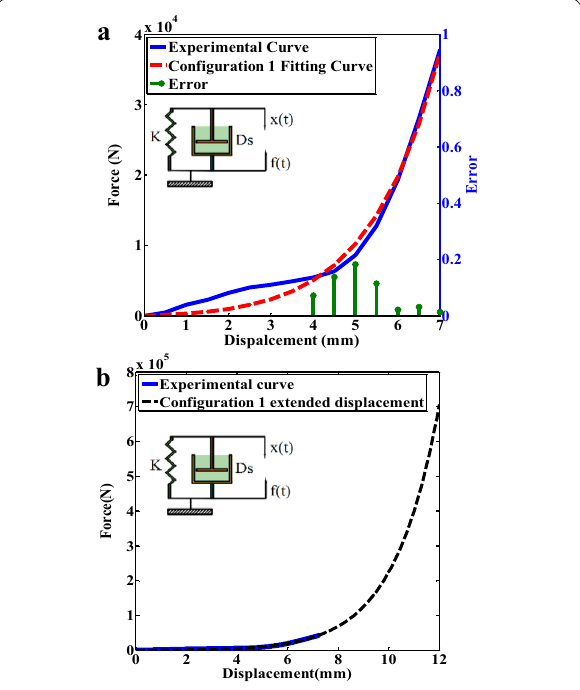
Figure 3 Configuration 1: equivalent mechanical model and verification results: a results of experiments and Eq. (9), b verification of the extended displacement of Eq.